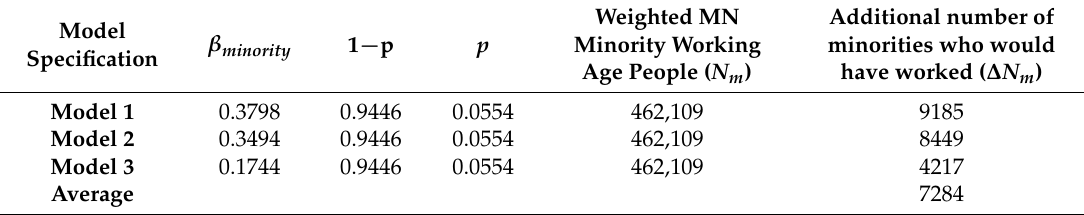
Table 4. Annualized additional number of minorities who would have worked had there been no disparity, ages 16–65 (2005–2007).